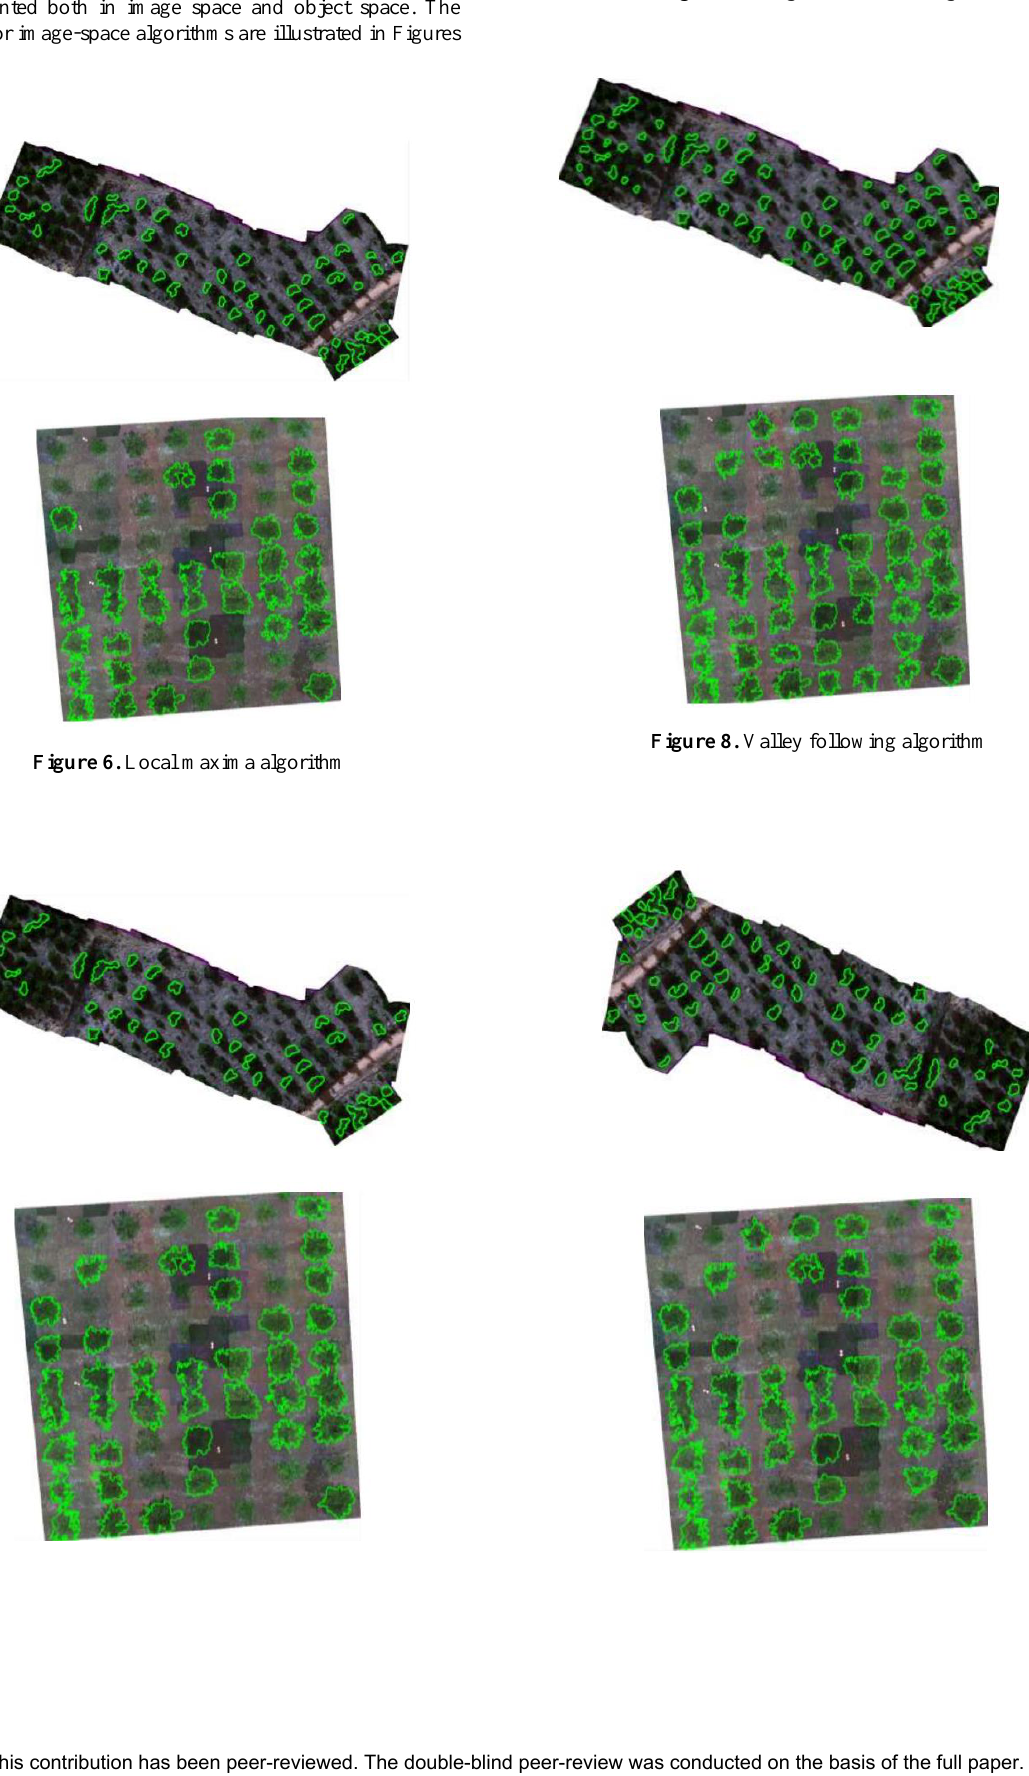
Figure 7. Image Binarization algorithm